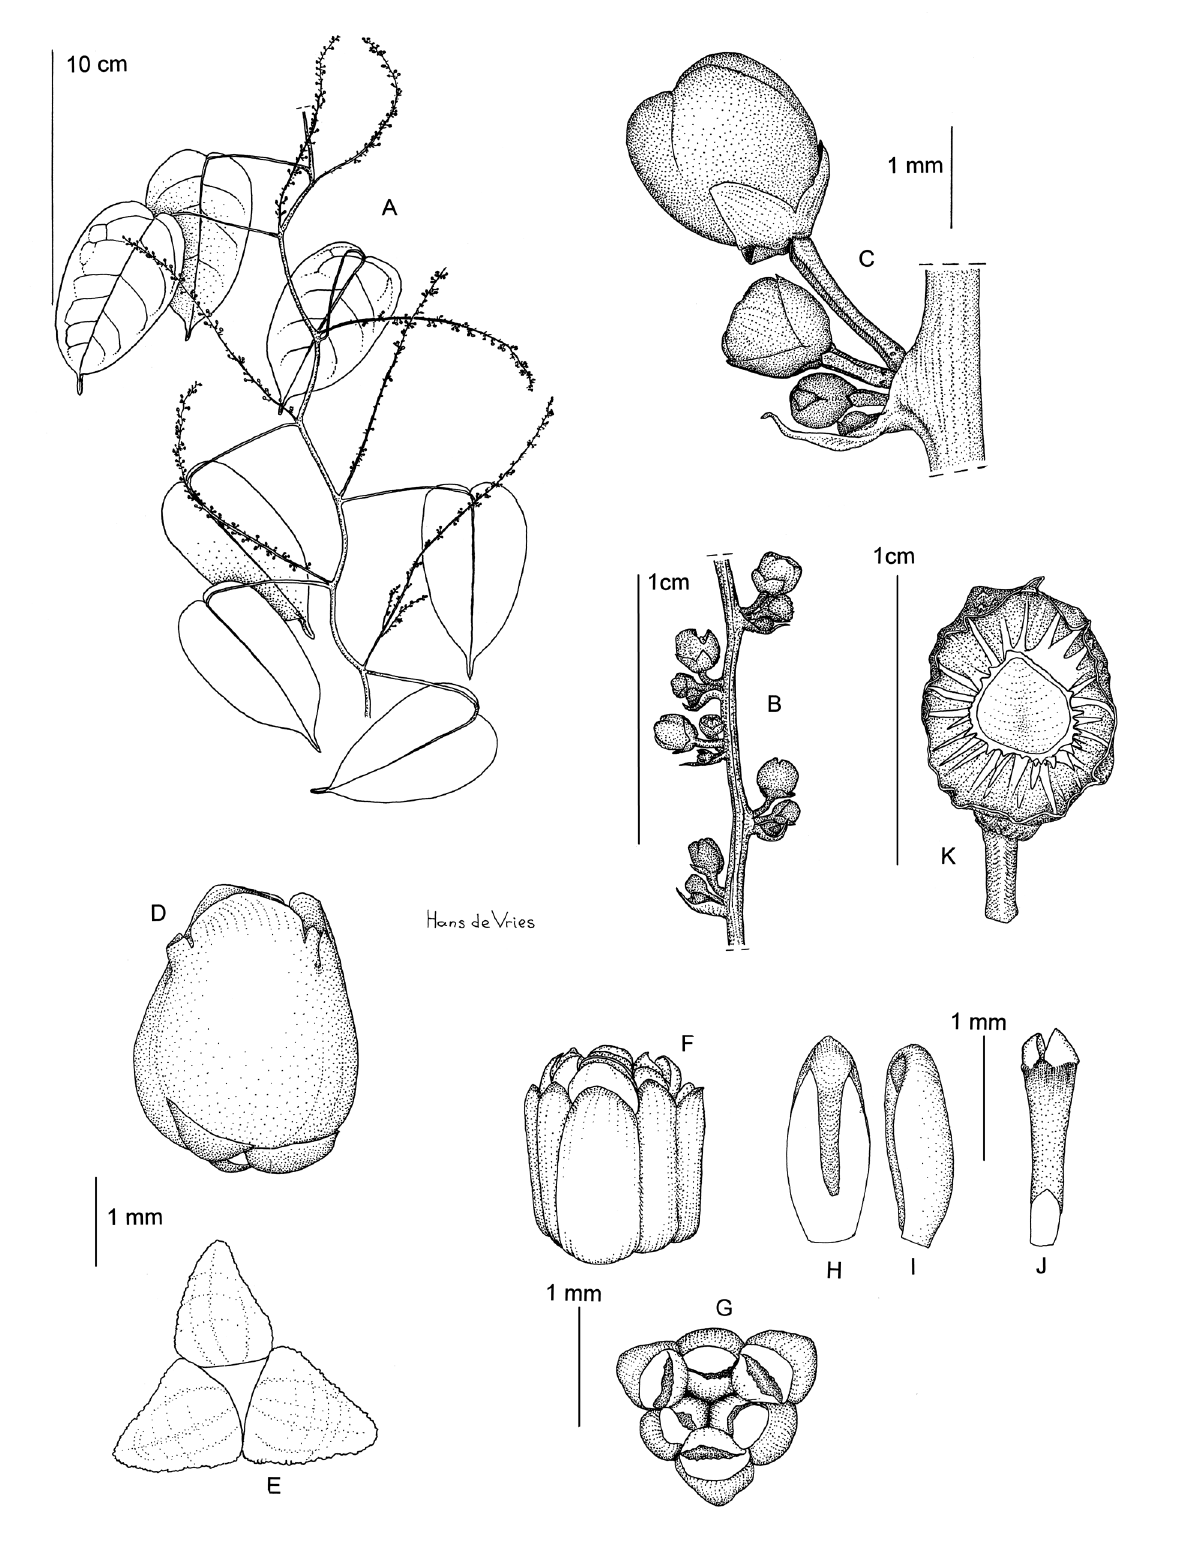
Figure 7 – Kolobopetalum synsepalum . A . Male leafy flowering branch. B. Part of male inflorescence. C . Detail of male inflorescence. D . Male flower. E . Outer calyx. F . Stamens surrounded by petals. G . Stamens and petals from above. H . Petal from inside. I . Petal laterally. J . Stamen. K . Fruit cut lengthwise. A–J from J.J. de Wilde, J.C. Arends & J. de Bruyn 9142 (holotype WAG); K from Sosef et al. 928 (WAG). Drawn by Hans de